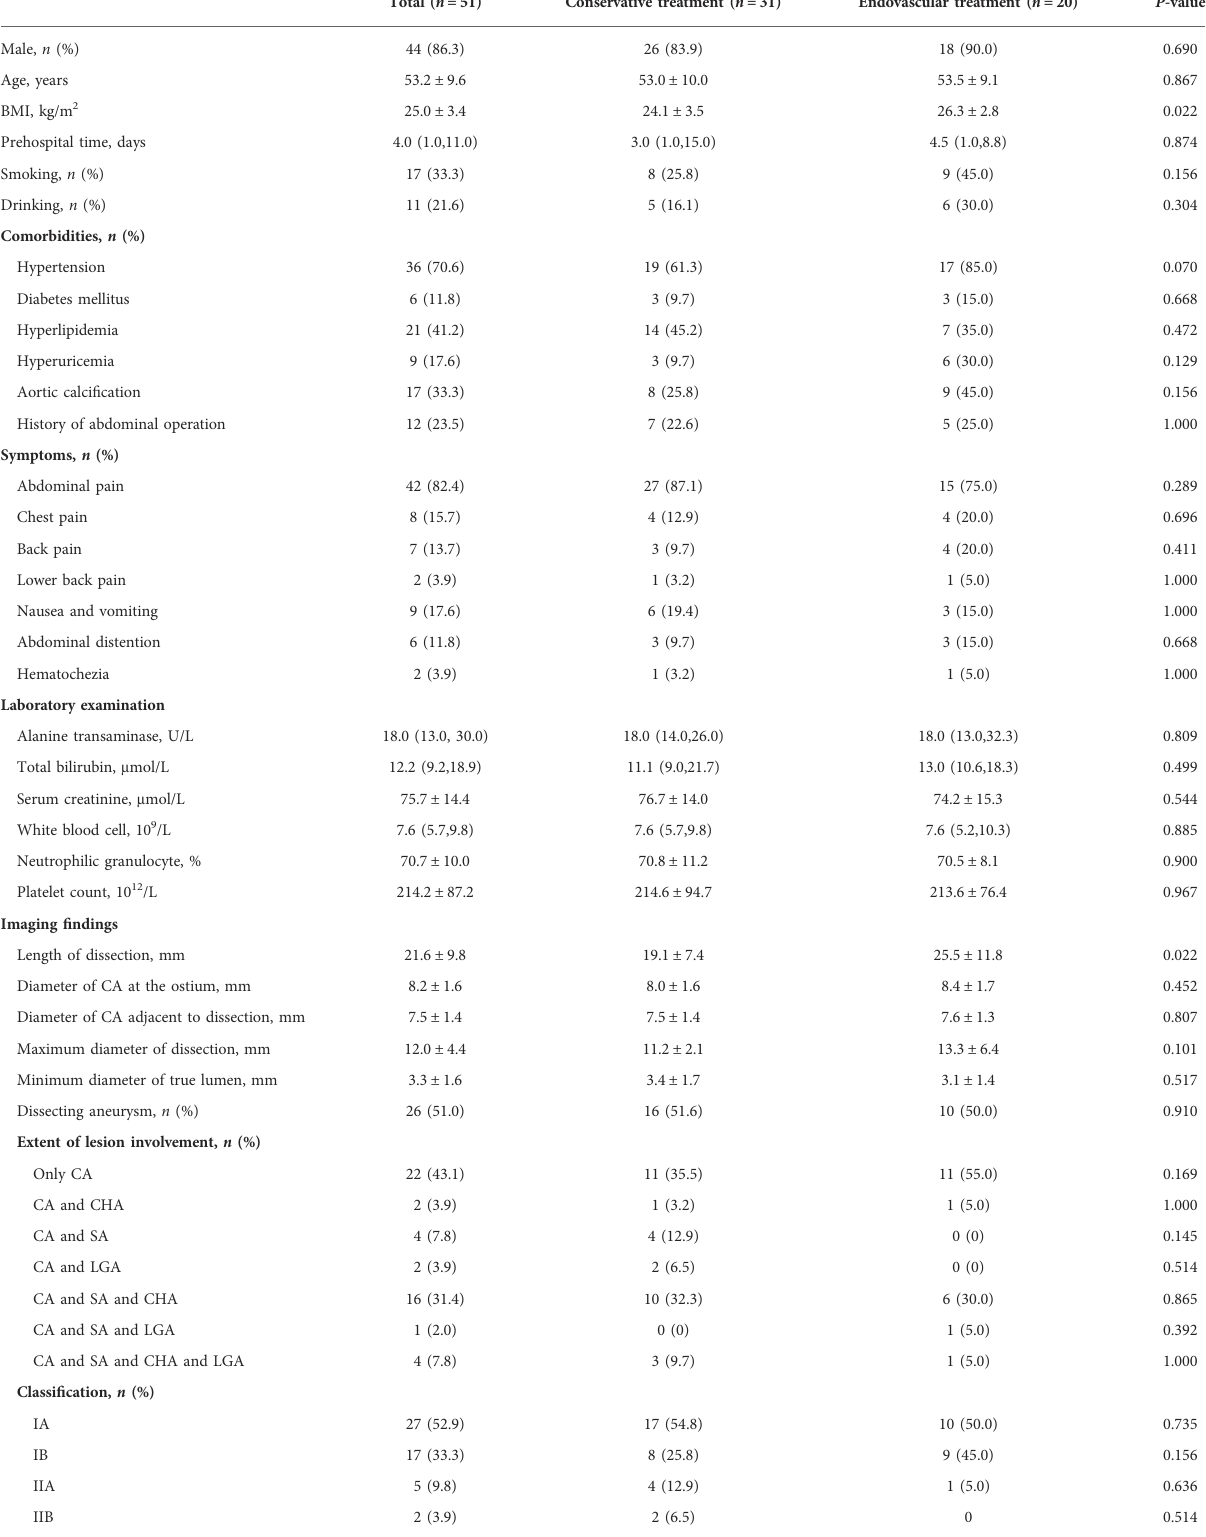
TABLE 1 Baseline data and CTA fi ndings of the patients with symptomatic